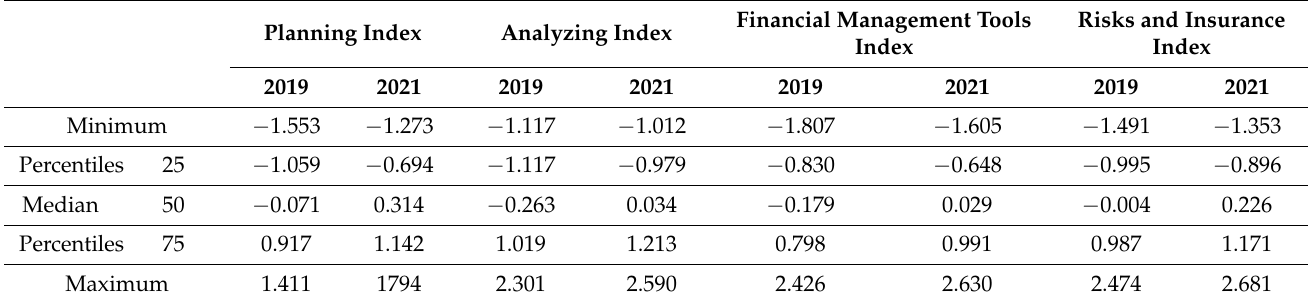
Table 3. Distribution characteristics of normalized indices.